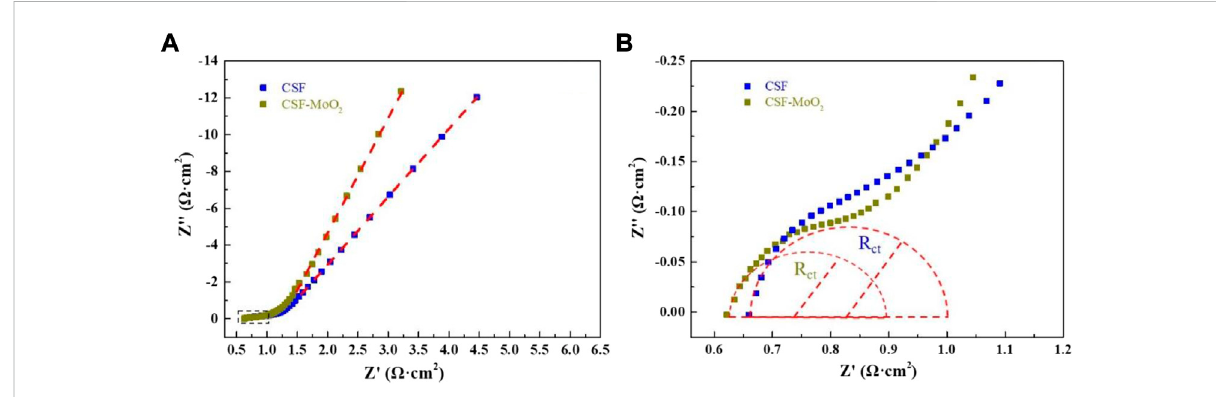
EIS spectra: (A) Nyquist plots of the CSF and CSF-MoO 2 electrodes, and (B) magni fi ed image of the area within the dashed box in (A)